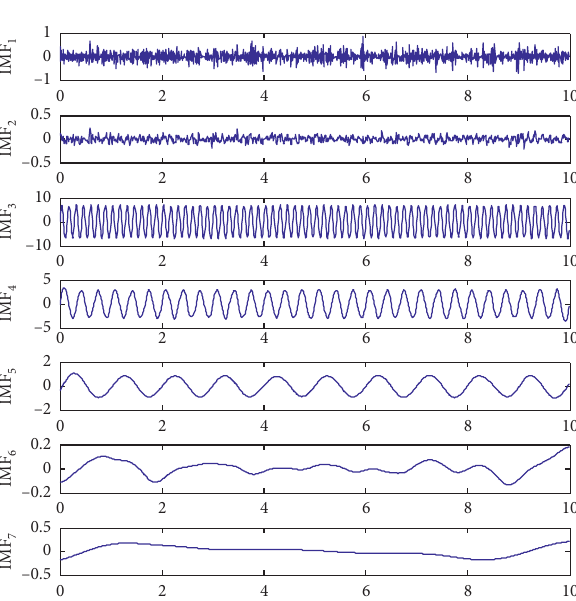
Figure 4: Signal and noise.